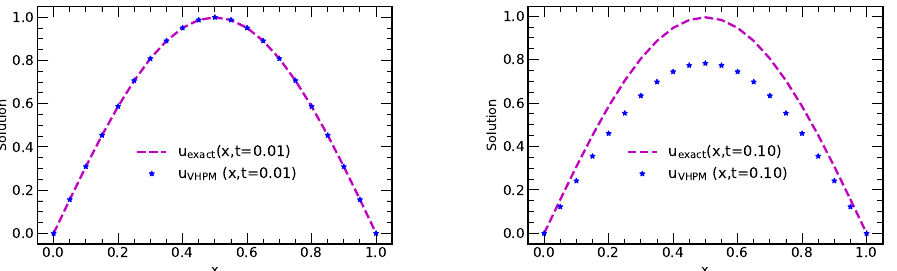
Figure 7. Plots of the exact and approximate solution vs. x at times 0.01, and 0.10 with ∆ x = 0.05, using n = 7 terms from VHPM.